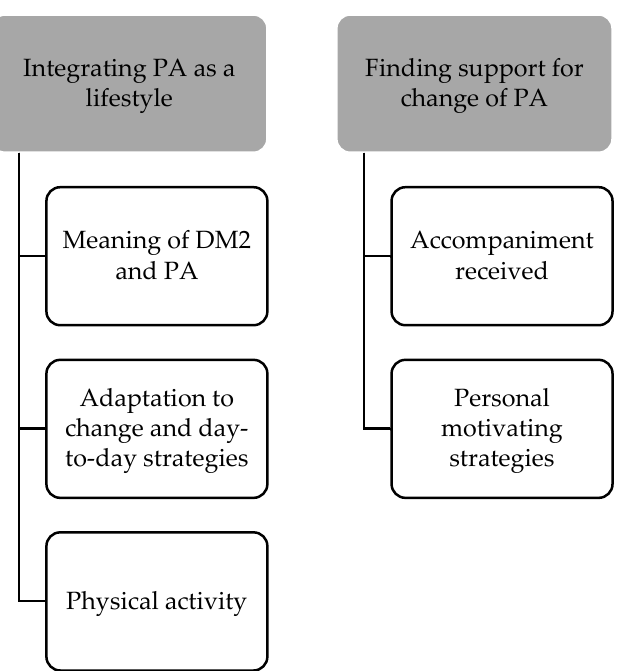
Figure 3. Inductive analysis themes and categories.